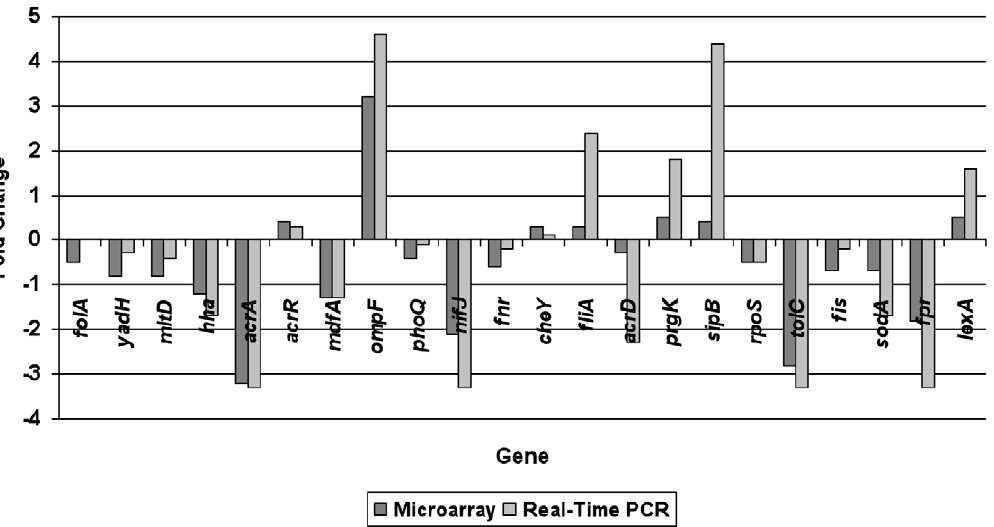
Figure 1. Comparison in expression ratios of 22 randomly selected genes between microarray and real time-PCR. The array fold- changes (in dark grey box) were based on averages from six biological replications. The fold differences ( D C T ) in expression levels of the genes tested using real time-PCR (in light grey box) were calculated from triplicate reactions against C T value of housekeeping gene ( rrsG ) of S . Typhimurium. acrA , tolC and ompF are genes showing significant difference ( $ 2-fold with P # 0.01) in microarray data.